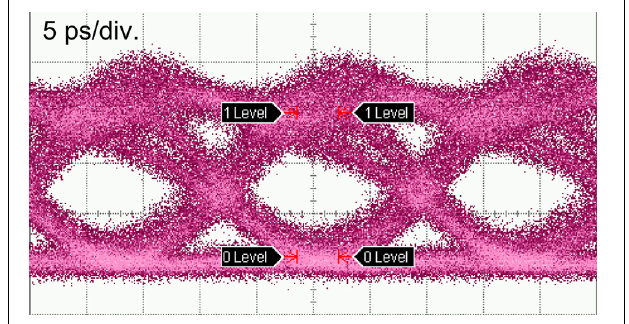
FIGURE 7 | 56-Gb/s optical output waveform obtained by using microring modulator in Figure